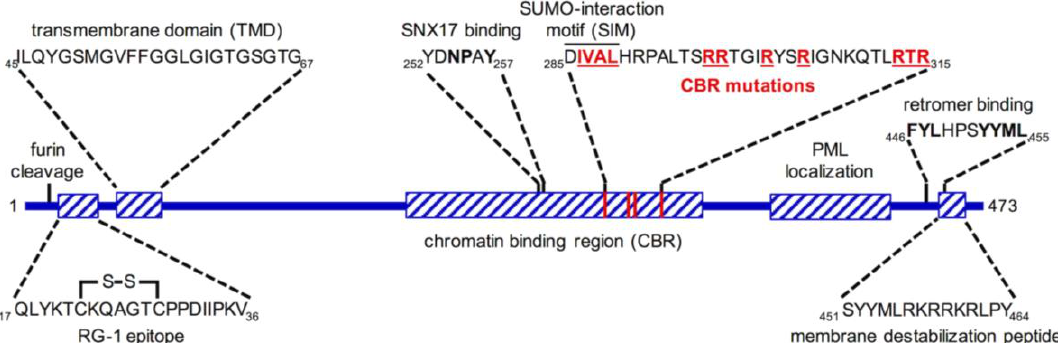
Figure 1. Diagram of the L2 protein. Positions of key components are illustrated. Relative distances and positions are to scale. Chromatin binding mutations are bolded and underlined in red to highlight the residues that were substituted.